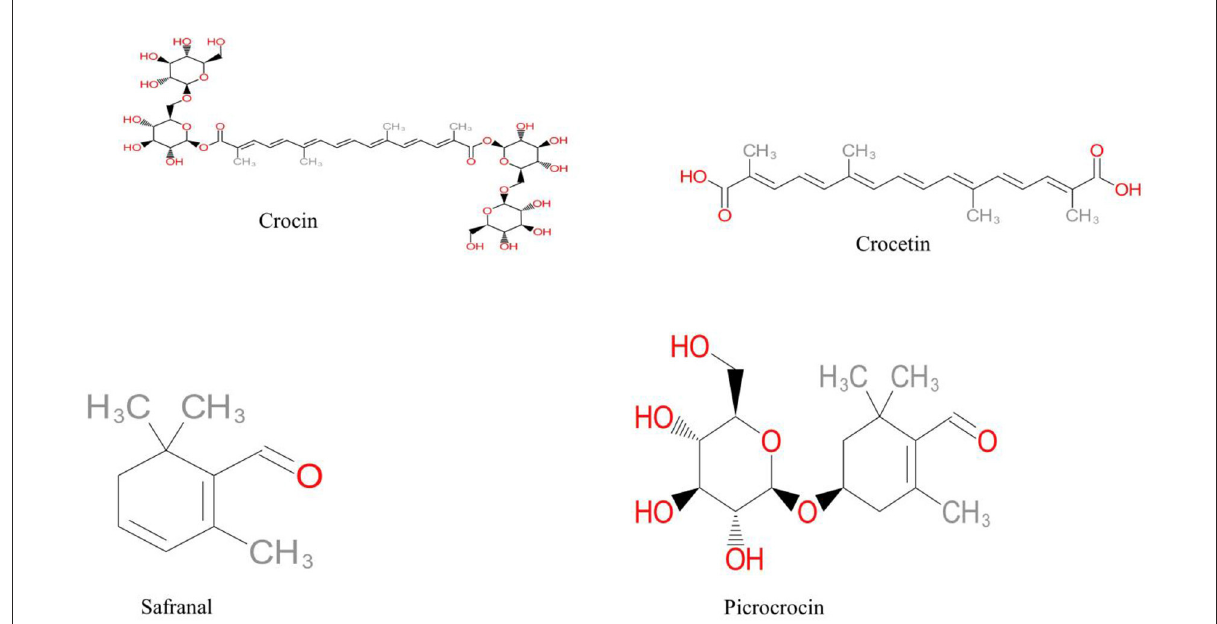
FIGURE1 Chemical structure of crocin, dicarboxylic acid (crocetin), monoterpen aldehyde (safranal) and glycoside